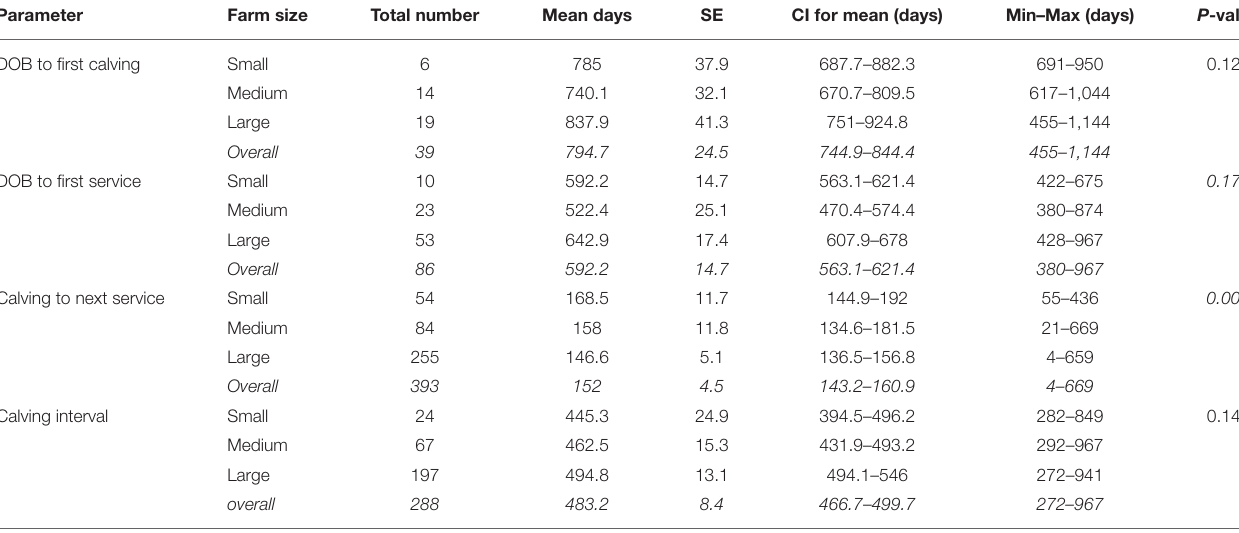
TABLE 4 | Fertility parameters during the study period.